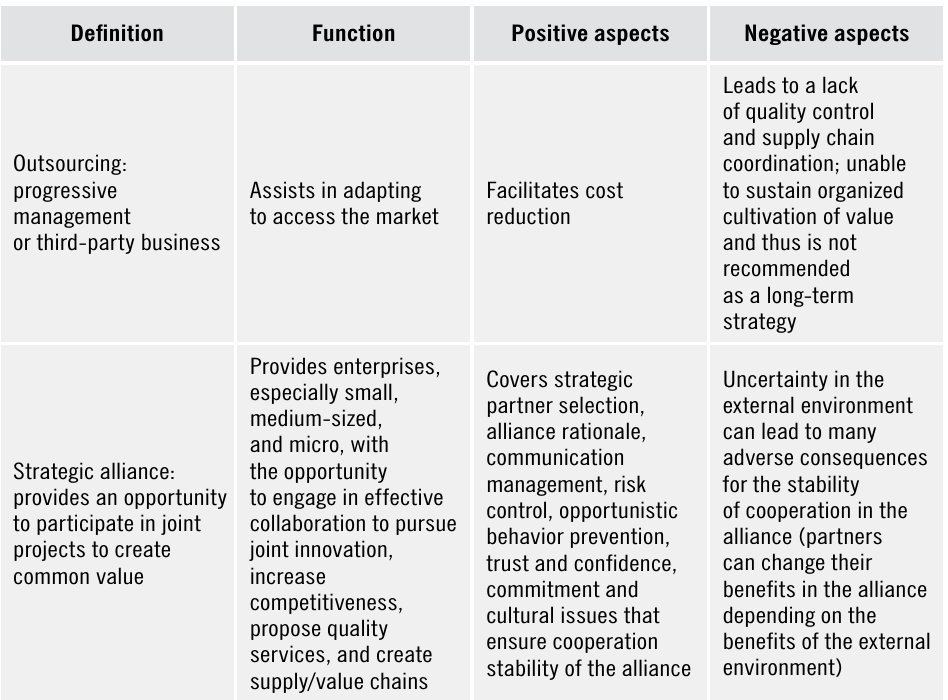
Table 4. Outsourcing and alliance as means of building a sustainable cooperative relationship: pros and